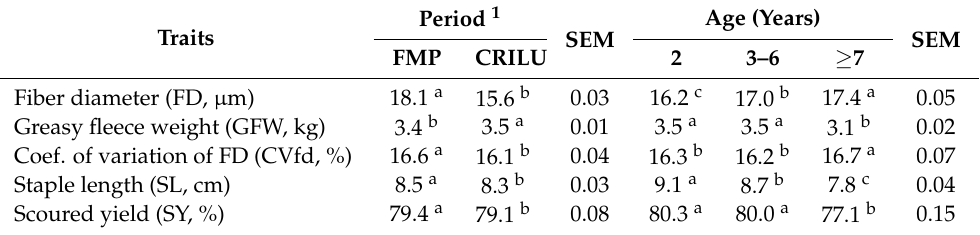
Table 3. Least square means (LSMs) and standard errors of the mean (SEMs) of the fiber diameter (FD, µ m), greasy fleece weight (GFW, kg), coefficient of variation of the fiber diameter (CVfd, %), staple length (SL, cm), and scoured yield (SY, %) by period and ewe age (1999–2020). Age (Years) Period 1 Traits SEM SEM FMP